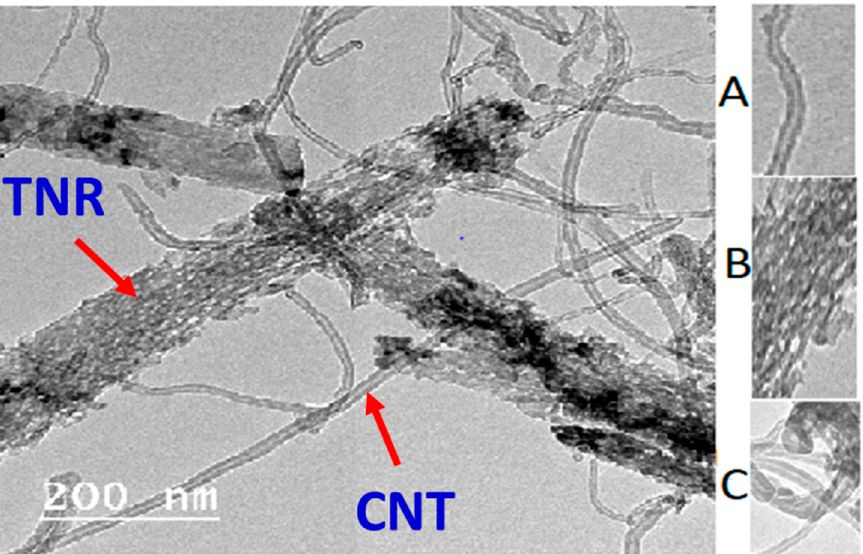
Figure 1. TEM image of nanocomposite with magnified parts for ( A ) MWCNTs, ( B ) nanopits distributed on nanoribbons surface, and ( C ) networking between nanoribbons and nanotubes.